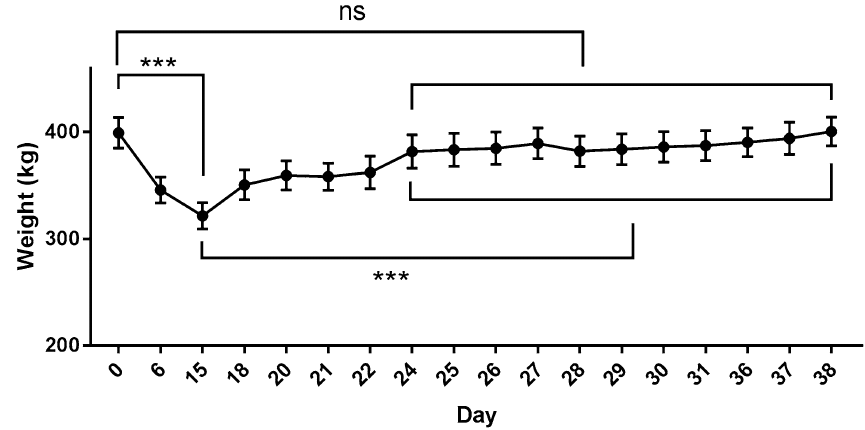
Figure 1. Changes in body weight of camels during the experiment (statistical analyses were performed using multiple unpaired t tests, *** p < 0.001; all error bars represent ± SEM).